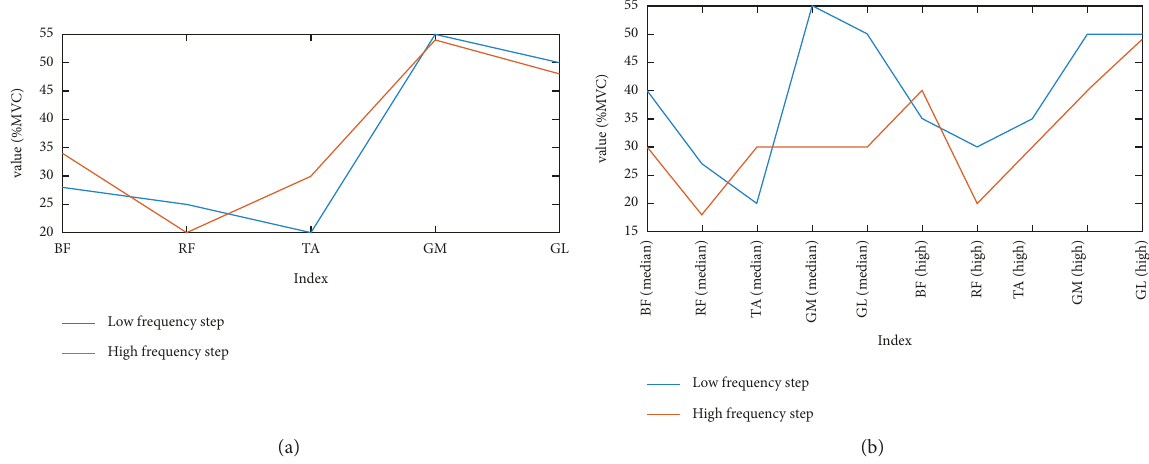
Figure 5: Analysis of lower limb stiffness at different frequencies. (a) Slow and (b) median speed and high